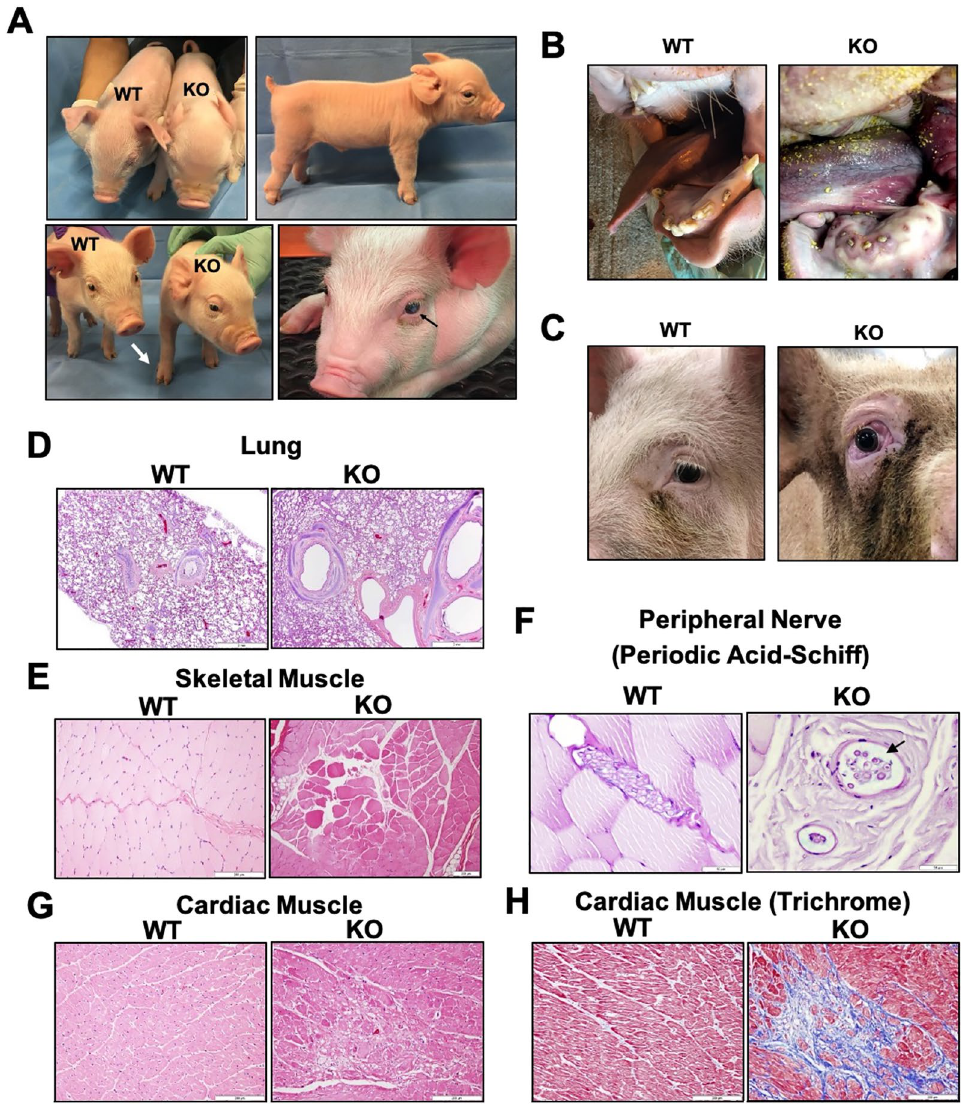
Figure 1. Anatomical and histological features of ANTXR1 KO pigs. ( A ) The photographs show examples of anatomical abnormalities in ANTXR1 KO pigs at two weeks of age. The upper left photograph shows an example of frontal bossing and shortened snout in the KO pig compared to a WT pig (left). The lower left photograph shows an example of a broadened stance (white arrow). The top right picture shows the post-legged rear legs of the KO pig. The bottom right picture shows an example of a KO pig with cataract (black arrow) in the left eye. ( B ) Presence of partial anodontia in the KO pig at one year of age. ( C ) Presence of excessive tissue development in the orbital socket with exophthalmos in the KO pig at one year of age. Representative images of hematoxylin and eosin (H&E) staining are shown for ( D ) lung, ( E ) skeletal muscle from the leg, and ( G ) cardiac muscle of WT and KO pigs at one year of age. ( F ) Periodic acid-Schiff staining was performed for skeletal muscle to show peripheral nerve degeneration with dilated fascicles filled with mucin (black arrow). ( H ) Masson’s trichrome staining was also performed for the cardiac muscle to show collagen accumulation (blue staining). Excessive collagen accumulation in the cardiac muscle was observed in several areas in the KO pig but not the WT pig. Scale bars are 2 mm for the lung, 200 μm for skeletal muscle and cardiac muscle, and 50 μm for the peripheral